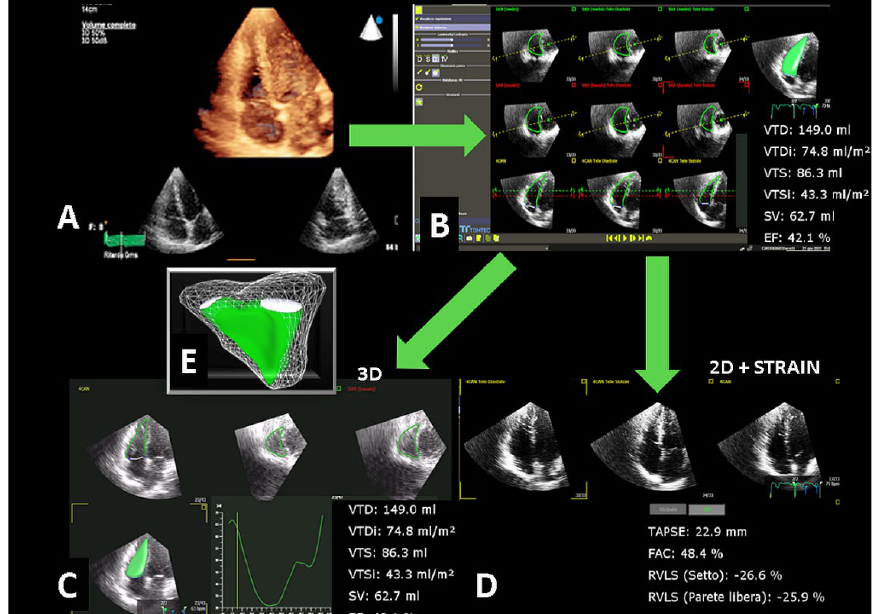
Figure 1. Step–by–step analysis of the RV: ( A ) Acquisition of the full volume from the 4–chamber apical view focused on the RV; ( B ) after acquisition the system is launched and in apparently 14 s the complete 3D analysis is obtained; in the same panel 3D–2D views allow editing of the borders in case of suboptimal contour; ( C , D ) by clicking the bottom a 3D analysis with functional curves or a 2D and strain measurements may be easily displayed; ( E ) the 3D dynamic model of the inflow, outflow and apex of the RV may be rotated and displayed